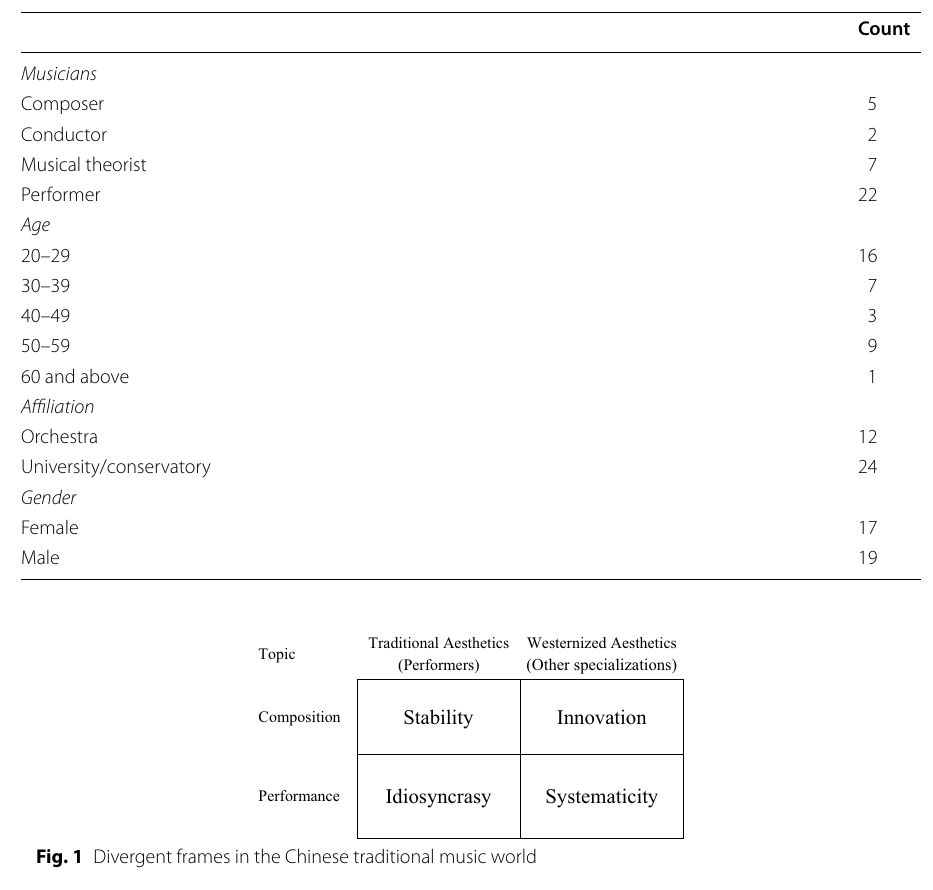
Table 1 Basic information of the respondents